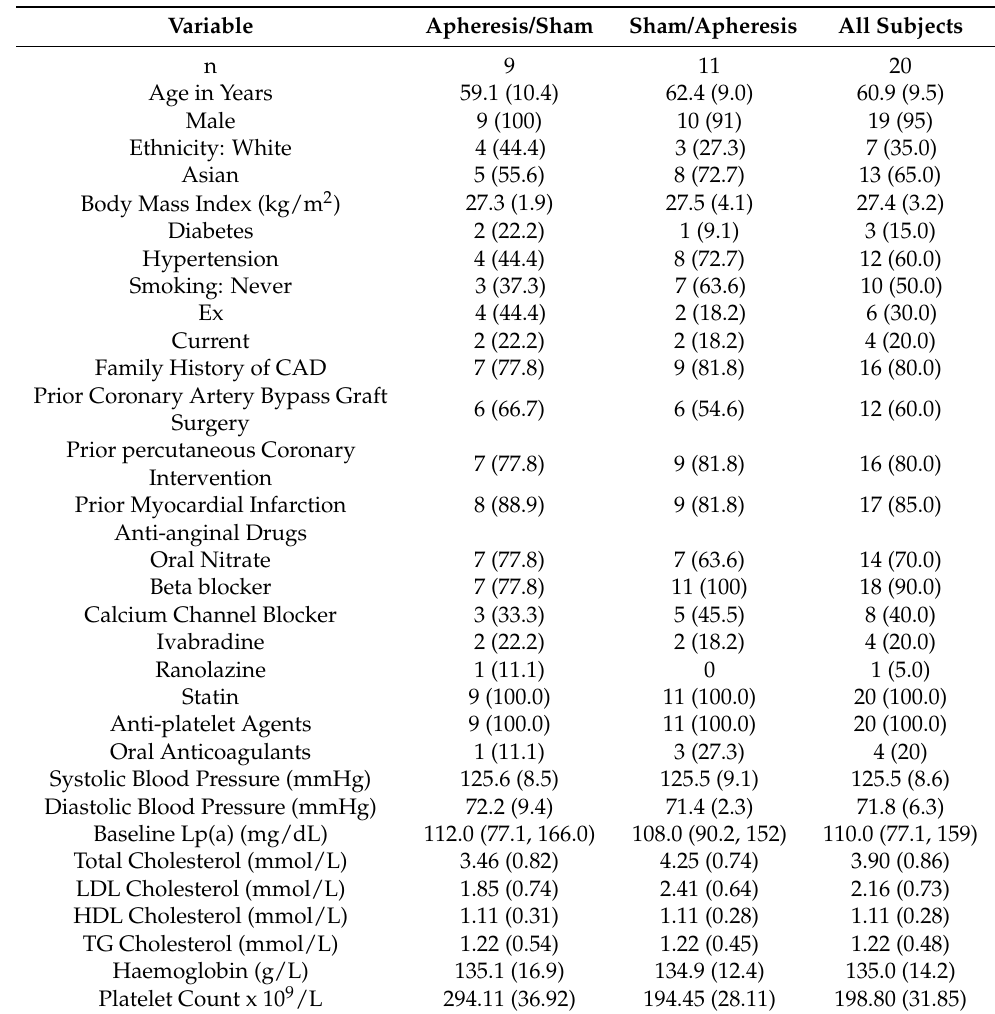
Table 1. Demographic and clinical characteristics at